Question: Write the caption for this figure.
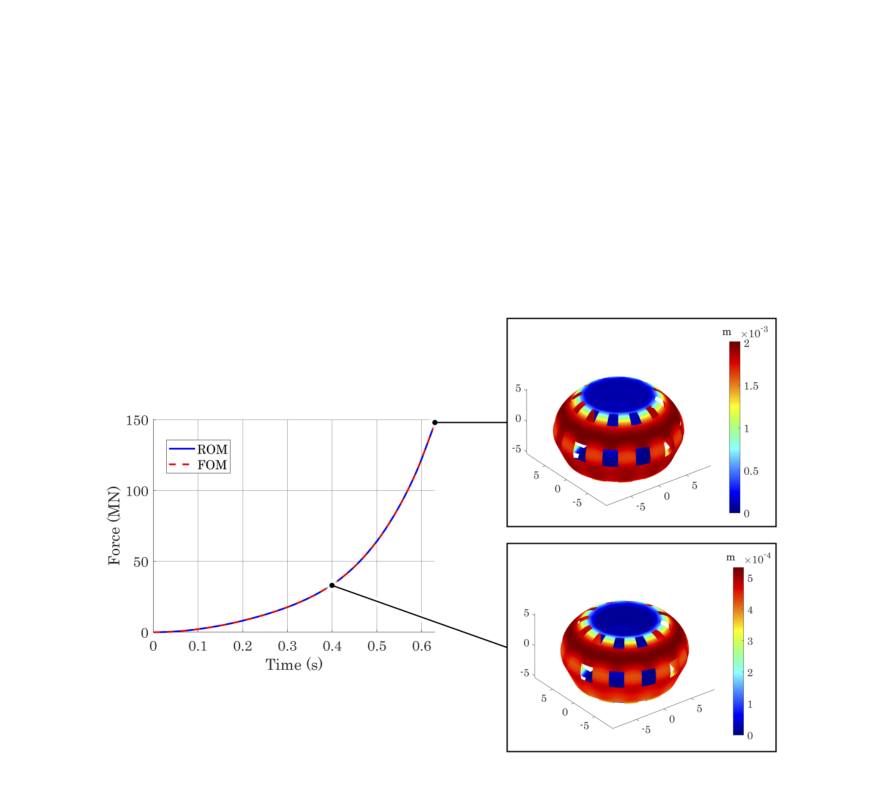
Answer: Trend of total force over the ITER-like Vacuum Vessel during the VDE evaluated with the FOM, and the ROM. The displacement magnitude is also reported at t = 0.4 s and at t = 0.63 s. Graphically the displacement is amplified by a factor α = 600.